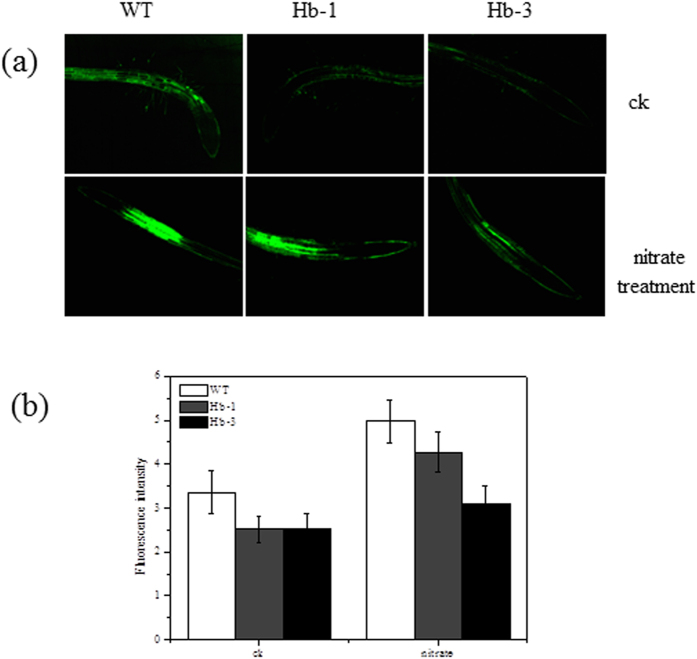
The NO fluorescence in SoHb transgenic Arabidopsis grown in MS medium with or without nitrate stress treatment.(a) Endogenous NO in Arabidopsis root was visualised using the DAF-FM DA with a confocal lasers scanning microscope system. (b)Average fluorescence intensity levels of root tips of WT and transgenic lines. The experiment was replicated three times with similar results. Bars = 100 μM.